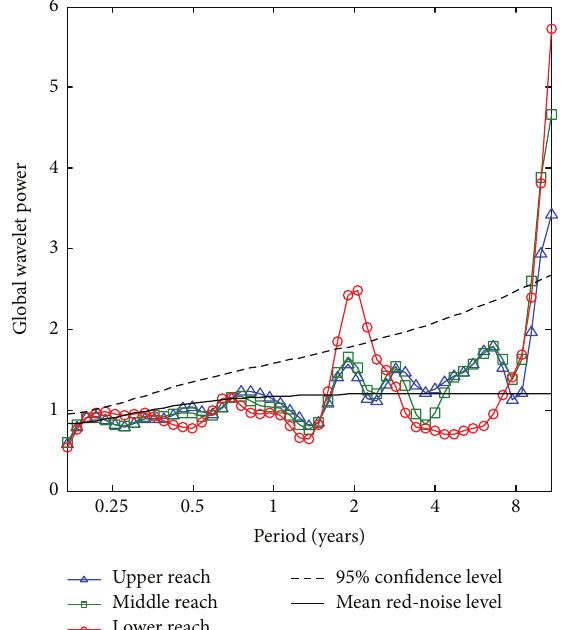
Figure6:Globalwaveletpowerspectrumforthemonthlyprecipita- tion anomalies in the upper, middle, and lower reaches of the Heihe River basin. The lower solid line is the mean read-noise spectrum, while the upper dashed line is the 95% confidence level for the global wavelet spectrum by assuming a red-noise process with the mean lag-1 autocorrelation of